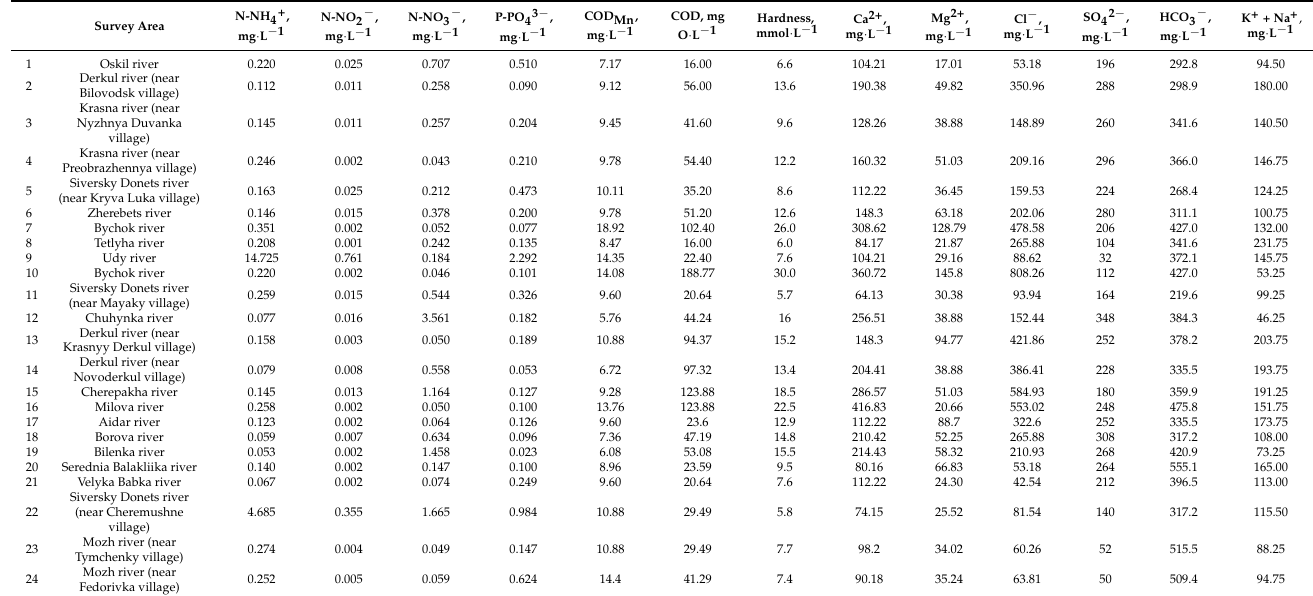
Table 2. The hydrochemical characteristics of water in sampling sites of the Siversky Donets river basin (Ukrainian part) in July–August of